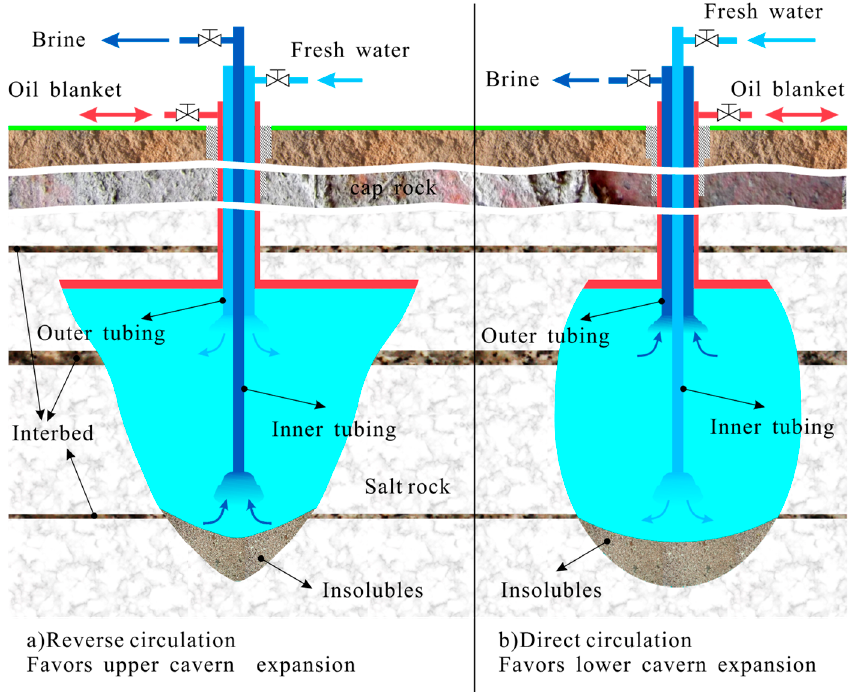
Figure 2. Schematic view of the salt cavern underground energy storage application. Fresh water or light brine is injected into the inner tubing, and high-concentration brine is expelled through the annular space in between the inner and outer tubings. This process is known as direct circulation, as distinguished from reverse circulation. Direct and reverse circulations are alternately employed until the salt cavern achieves the design shape and dimensions.